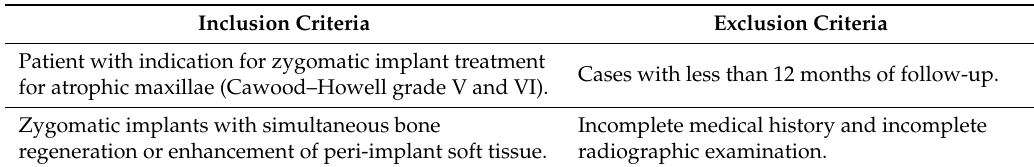
Table 1. Patient selection criteria.